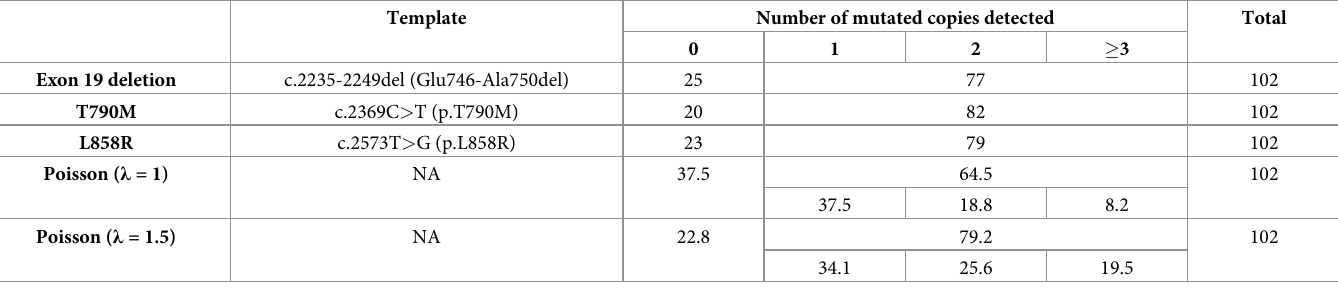
Table 1. Repeatability and accuracy evaluation of SensiScreen 1 EGFR Liquid assays: Number of copies mutated for Exon 19 deletion, T790M or